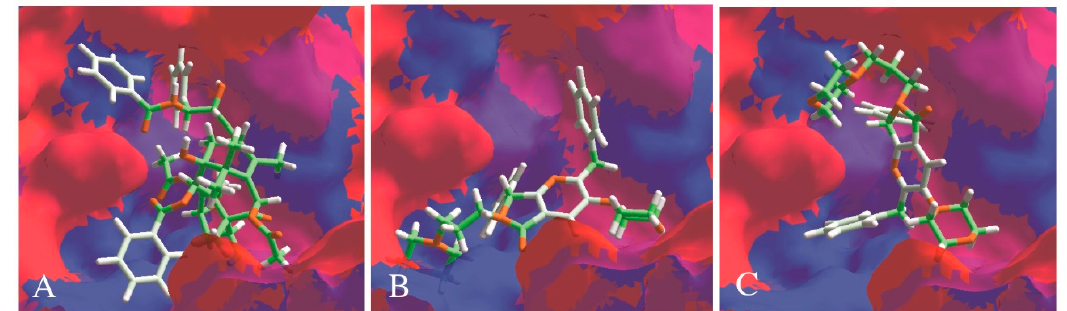
Figure 7. Hydrophobicity interactions between the αβ -tubulin with ( A ) Paclitaxel, ( B ) 1k (enantiomer R), and ( C ) 1k (enantiomer S). Color key: The blue color depicts hydrophobic surfaces, the red color depicts hydrophilic surfaces, green sticks depict hydrophobic moieties, and orange sticks depict hydrophilic moieties.